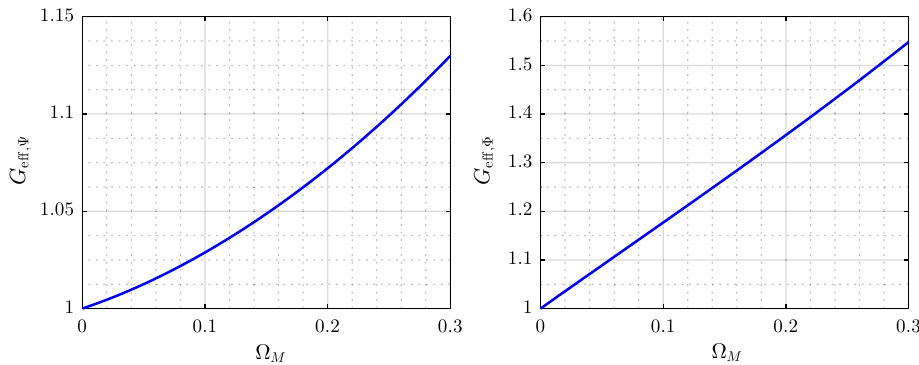
Fig. 2 Plotsof1 / 8 π m 2 and1 / 8 π m 2 respectivelyversus (cid:2) M .TheseareproportionaltotheNewton’sconstantforeachpotentialrespectively. eff ,(cid:5) eff ,(cid:4) Note that the one for (cid:4) decreases faster than (cid:5)